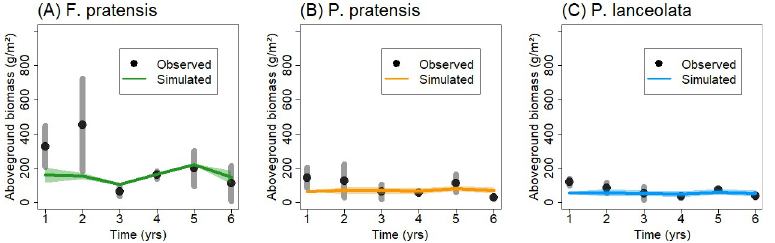
Fig 1. Aboveground biomass dynamics for three monocultures. Black dots show observed values and colored lines represent the simulated dynamics of (A) F . pratensis , (B) P . pratensis and (C) P . lanceolata using the model GRASSMIND (annual average and vertical grey lines/polygons denote the intra-annual range of two censuses per year).